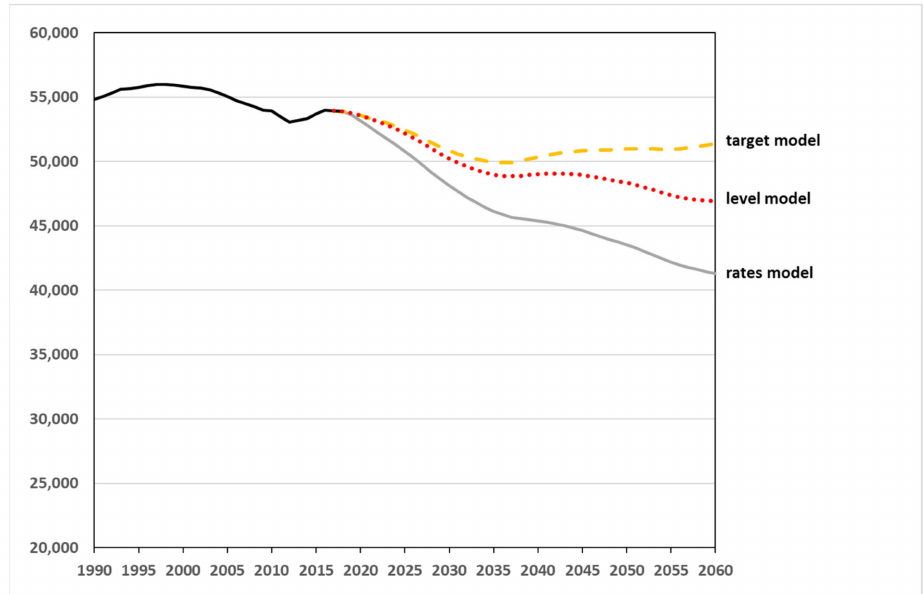
Figure 8. Development of the population aged 15–64 until 2060—simulation results from 2019 onwards. (Sources: [64]; own computation and